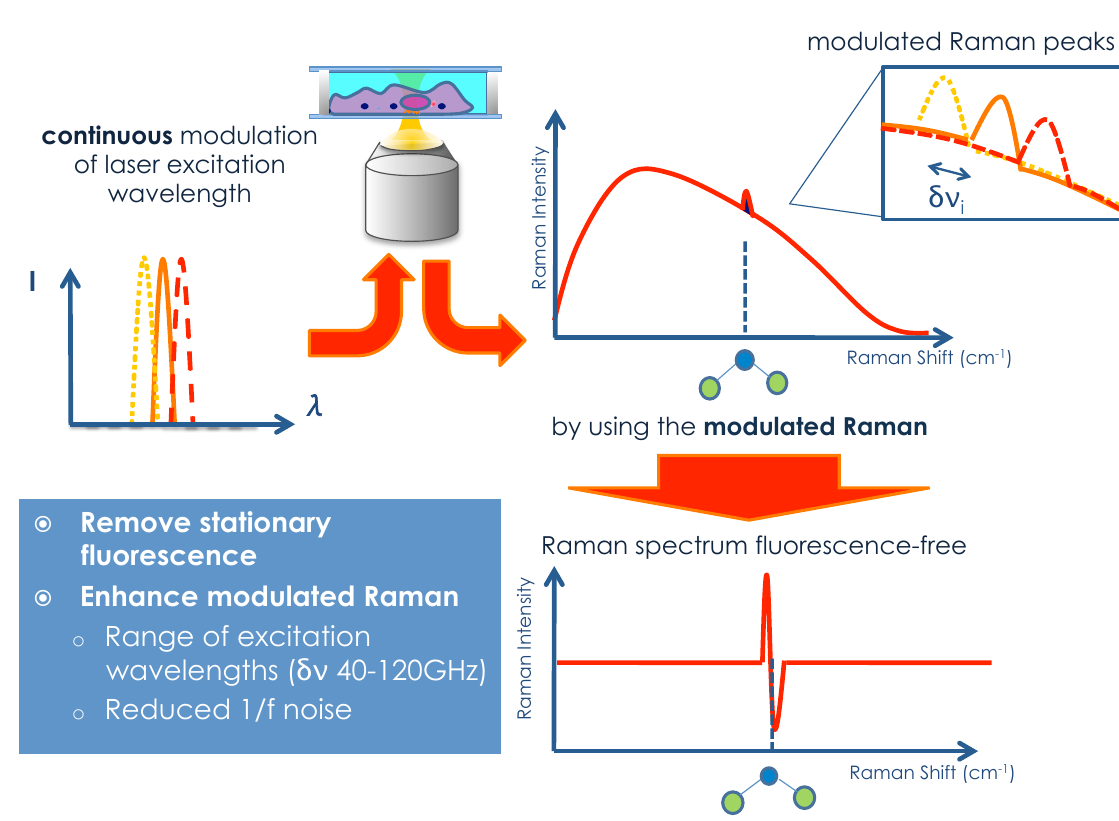
Figure 3. Scheme of the modulated Raman